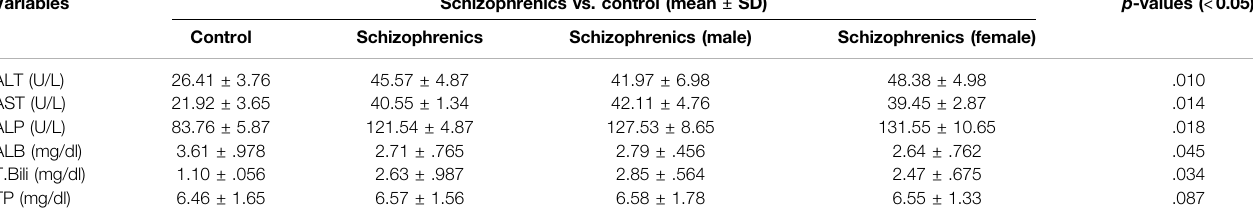
TABLE 3 | Hepatic pro fi les of schizophrenics versus controls.